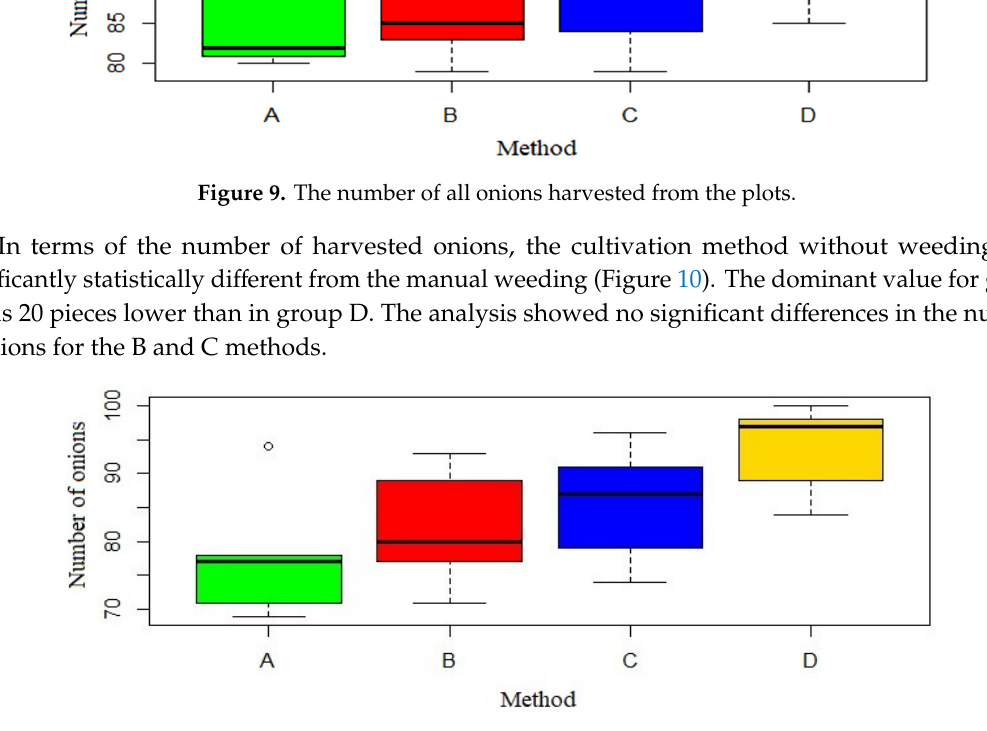
Figure 10. The number of onions harvested from the plots, which is the productive yield.